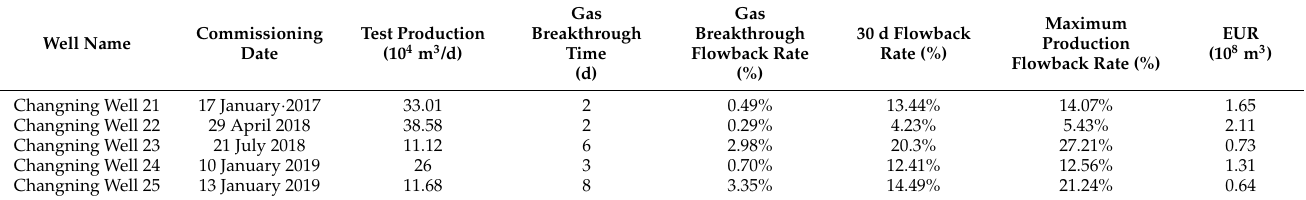
Table 5. Flowback evaluation index data of typical production wells in Changning